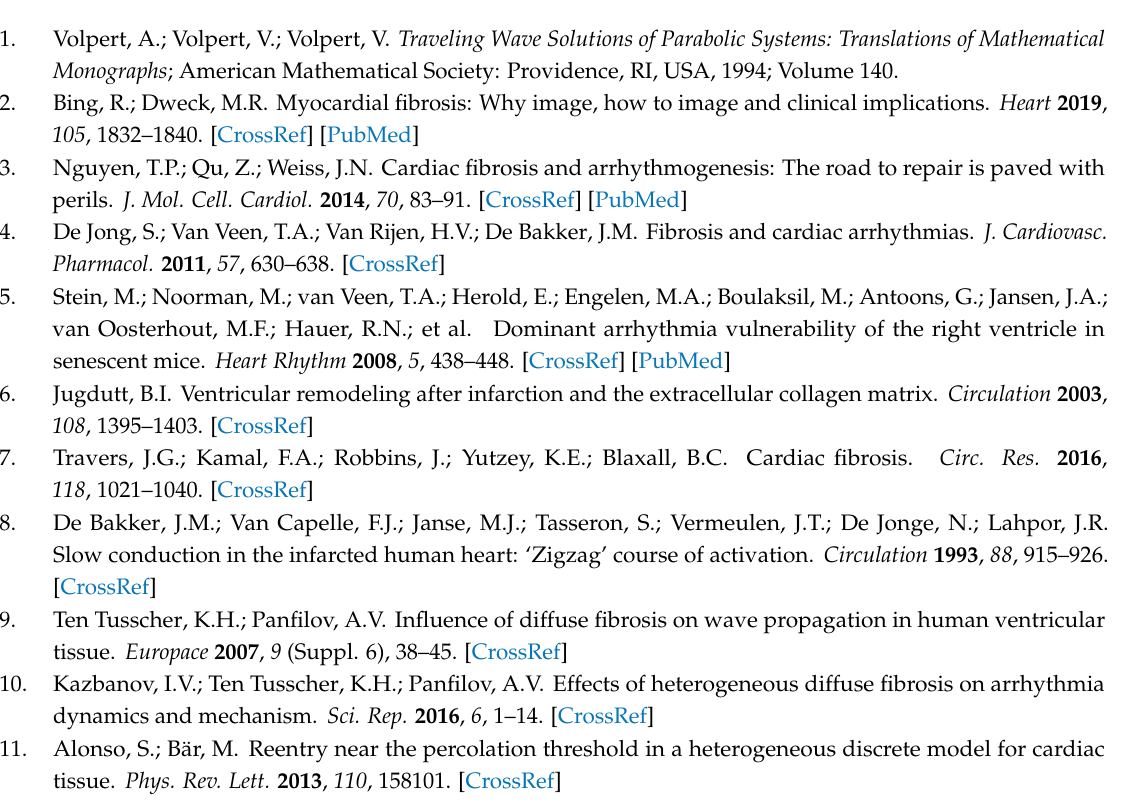
Figure S1: Electrical wave propagation in a model with structural fibrosis and a reduced model simulating propagation timing in the fibrosis tissue. Table S1: Electro-diffusion coefficients (D), anisotropy (longitudinal to transverse ratio) and conduction velocity (CV) in the models with structural fibrosis and corresponding reduced